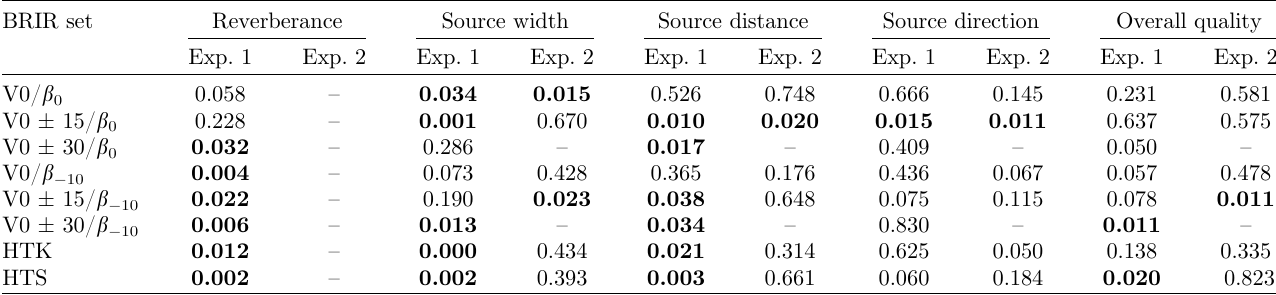
Figure 7. (Experiment 1) Perceptual ratings averaged over three repetitions, for fi ve perceptual attributes, four source positions, and eight different BRIR sets. Table 2. p -values (Friedman test) for investigating the effect of source position on the ratings given to different BRIR sets for each perceptual attribute in Experiment 1 (Exp. 1) and Experiment 2 (Exp. 2). p -values indicating signi fi cant different ratings ( p < 0.05) are depicted as bold